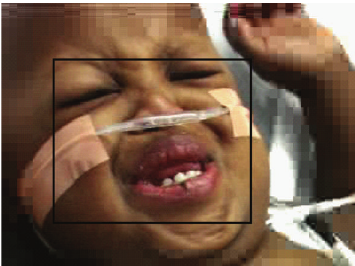
Figure 5: Representative ROI-encoded frame of video Er08 at 500 kbps with elastic bit